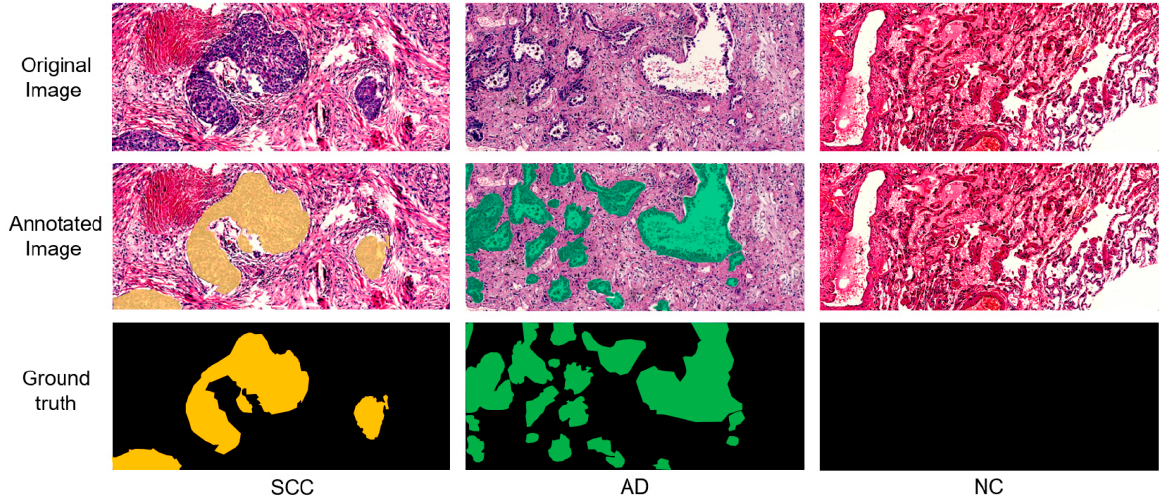
Figure 2. The first row shows examples of the original images scanned from histopathologic slices. The second row shows the annotated images where pathologists highlighted the lesion regions. The third row shows binary masks for the segmentation task. The third row shows binary masks for the segmentation